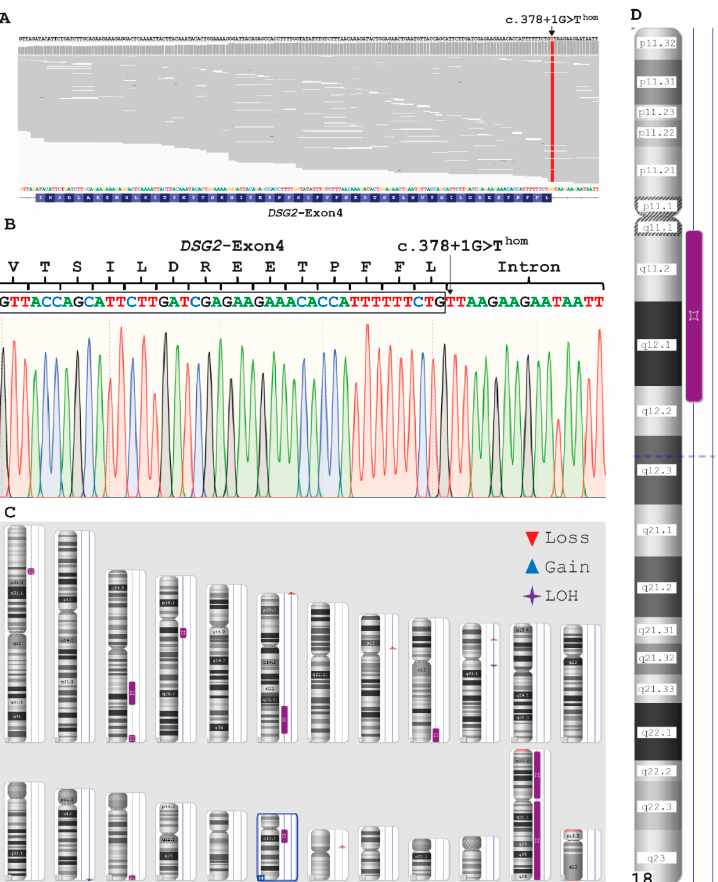
Figure 6. Genetic analysis of II-1 (Family A). ( A ) Integrated genome view of exon 4 in DSG2 of patient II-1. ( B ) Electropherogram of exon 4 in DSG2 (II-1). The mutation DSG2–c.378+1G>T is affecting the donor splice site and is found in a homozygous status. ( C ) Karyoview of II-1. LOH = loss of heterozygosity. (D) Detailed ideogram of human chromosome 18 revealing a 15.6 Mb loss of heterozygosity (LOH).